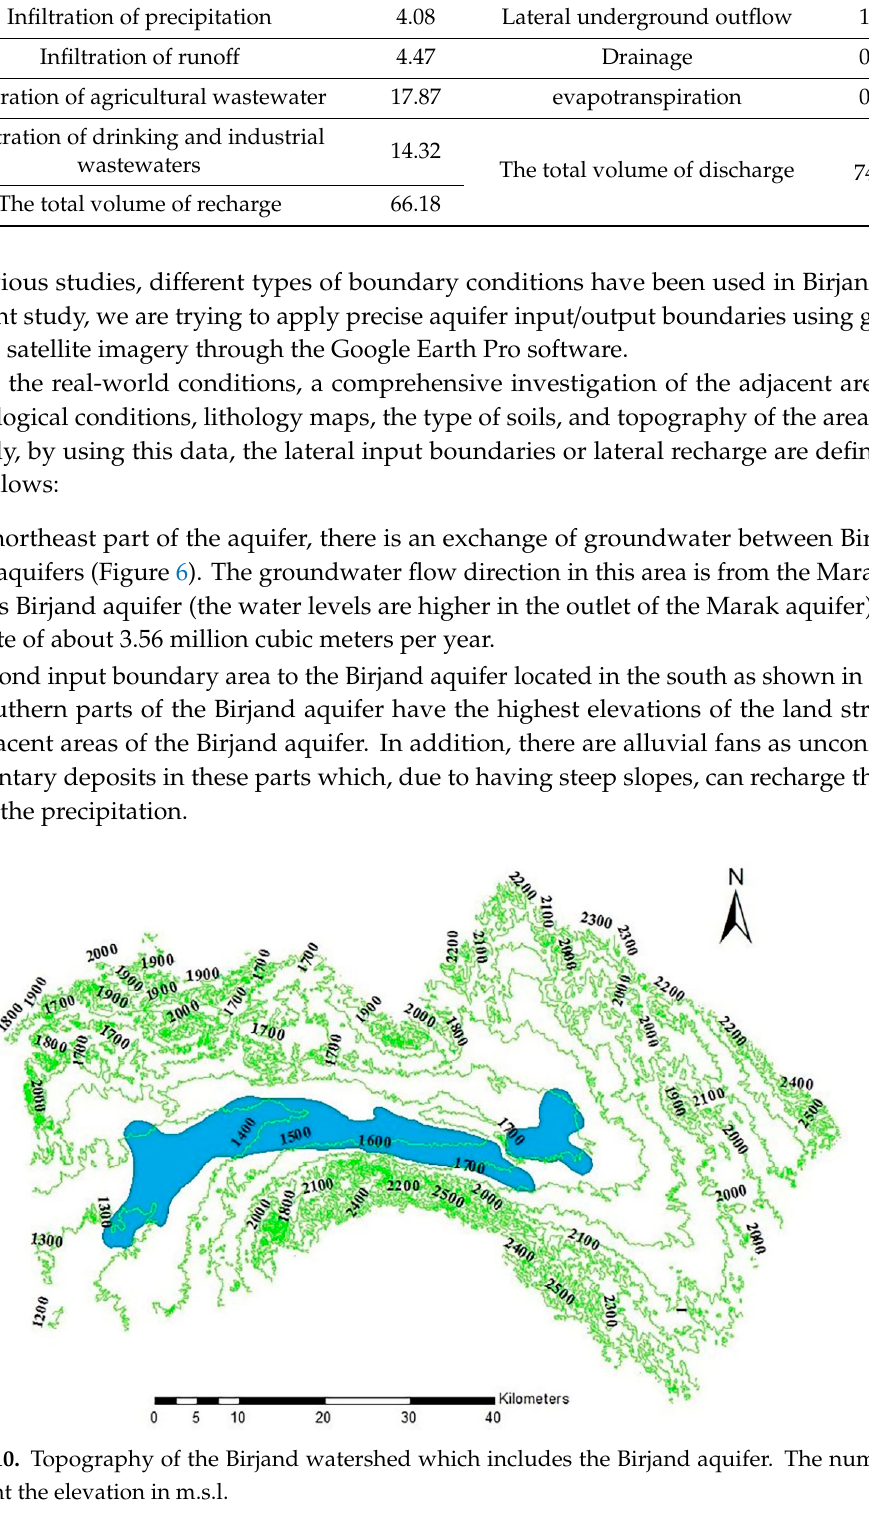
Table 1. Birjand aquifer budget provided by RWCSK [64]. The values are in million cubic meters (MCM) per year.